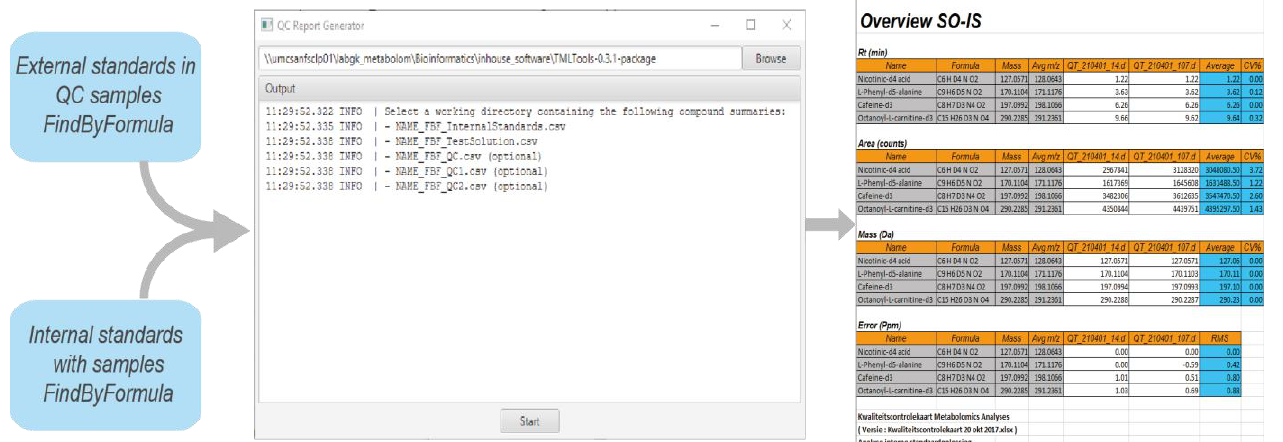
Figure 5. Screenshot of the QC reporting tool along the excel-based report.